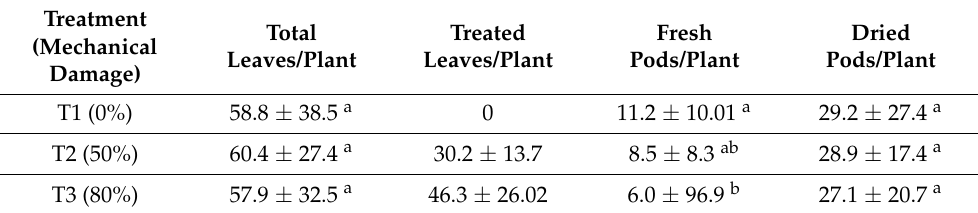
Table 1. Number of leaves treated with mechanical damage and number of fresh and dry pods obtained from Tepary bean ( Phaseolus acutifolius